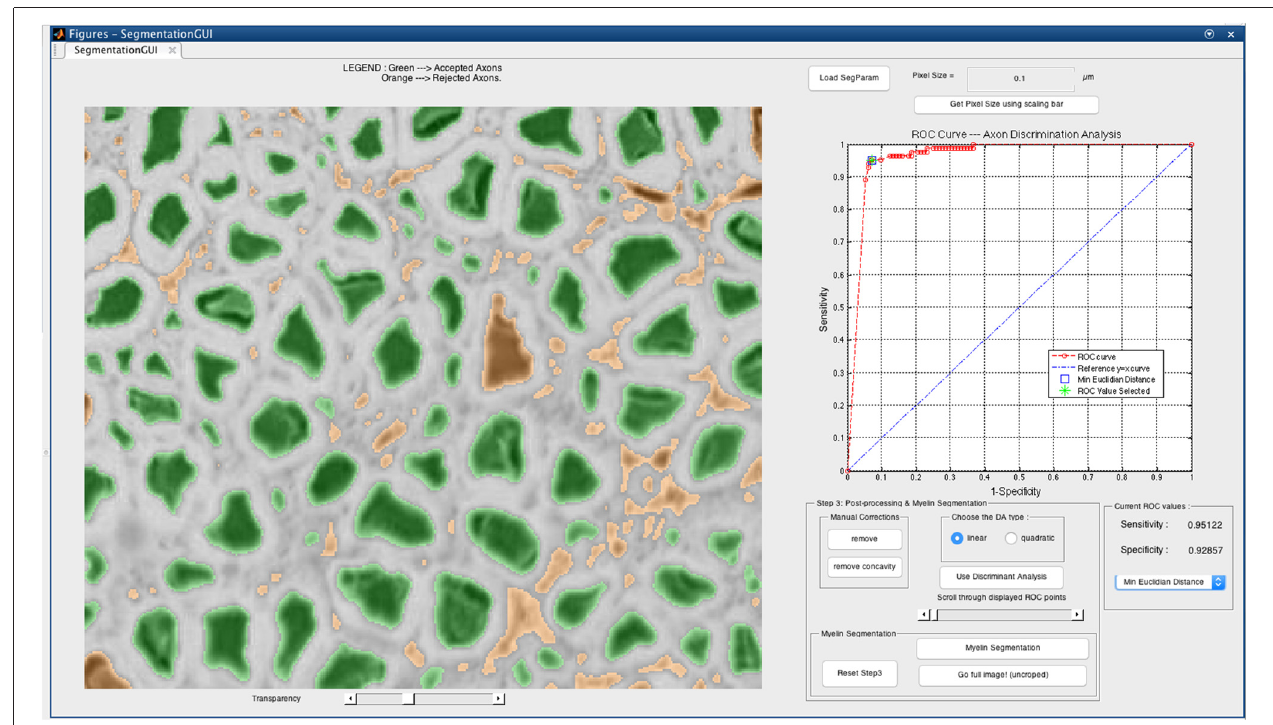
FIGURE 2 | Discriminant analysis (DA) step in the AxonSeg graphical user interface (GUI). The user can scroll through available sensitivity and specificity combinations and display the results. For each sensitivity/specificity value, accepted axons are displayed in green while rejected axons are displayed in orange. The user can also decide to select a receiver operating characteristic (ROC) metric (e.g., minimal Euclidian distance, maximal sensitivity, maximal specificity). When satisfied with the DA classifier, the user can launch the myelin